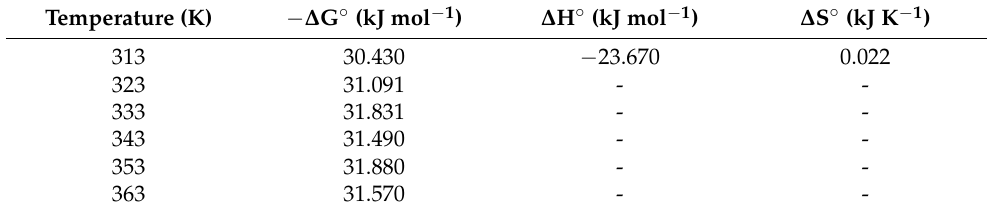
Table 6. Thermodynamic studies for the sorption of MY on CPSMNPs.